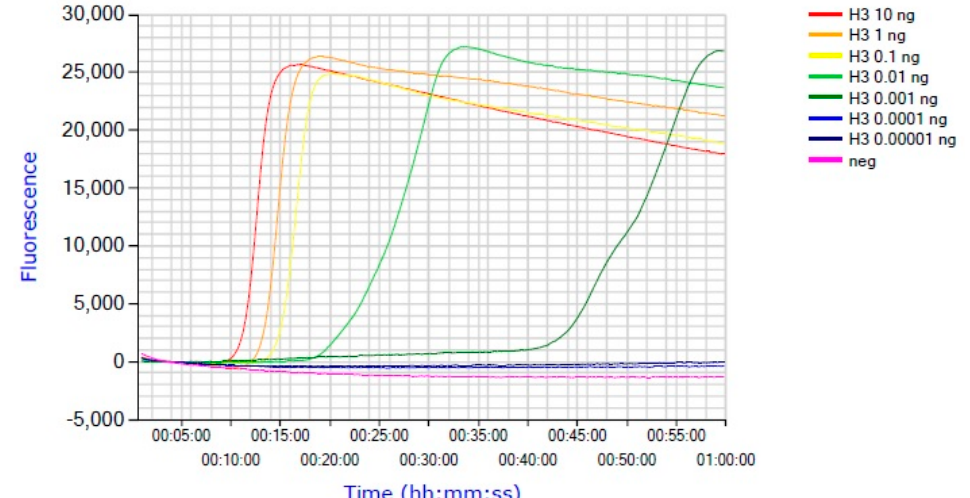
Figure 3. Determining the sensitivity of the LAMP reaction. Isolate H3 = D. septosporum (DSEP-Kingfisher-Ne1). Positive results for concentrations from 10 to 0.001 ng/ µ L. Negative results for 0.0001 ng/ µ L, 0.00001 ng/ µ L, and negative control